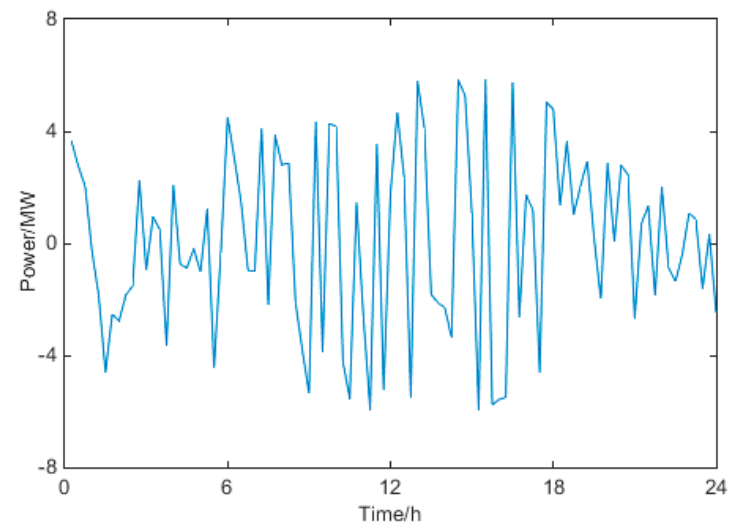
Figure 6. The output curves of typical scenario 2.